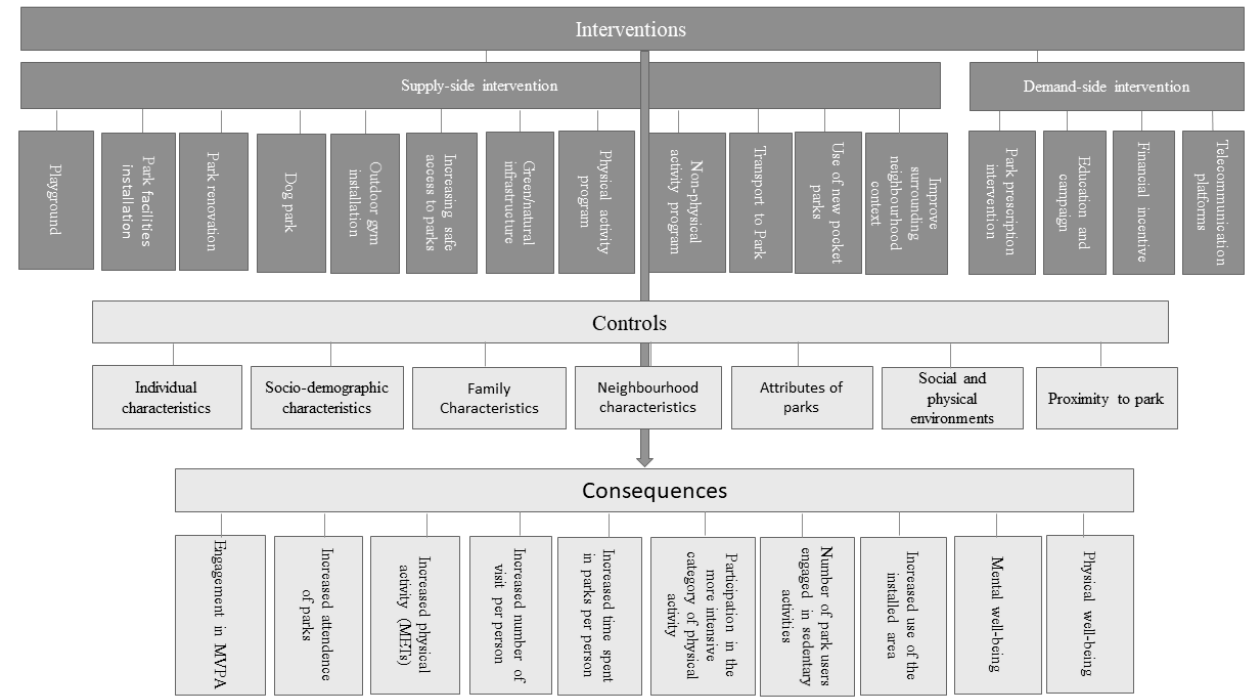
Figure 6. Casual pathways between interventions and park-based physical activities. Source: Authors’ own design.